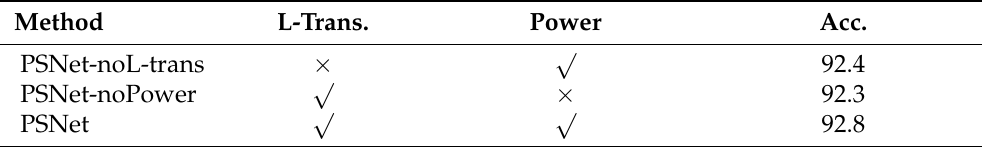
Table 4. Ablation study on linear transform and power operation in the PSConv layer. We present shape classification accuracy on ModelNet40 (OA in %). L-Trans. denotes linear transform. The model with both linear transform and power operation performs best.